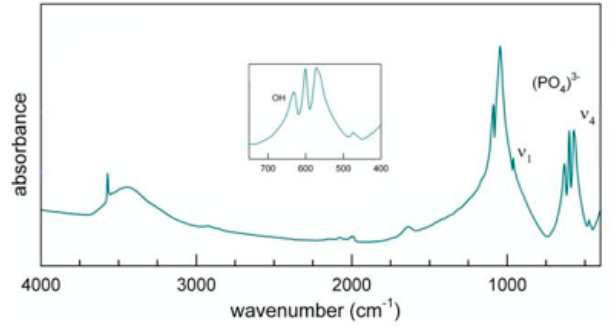
Figure 6. FTIR spectrum of synthetic HAp (900